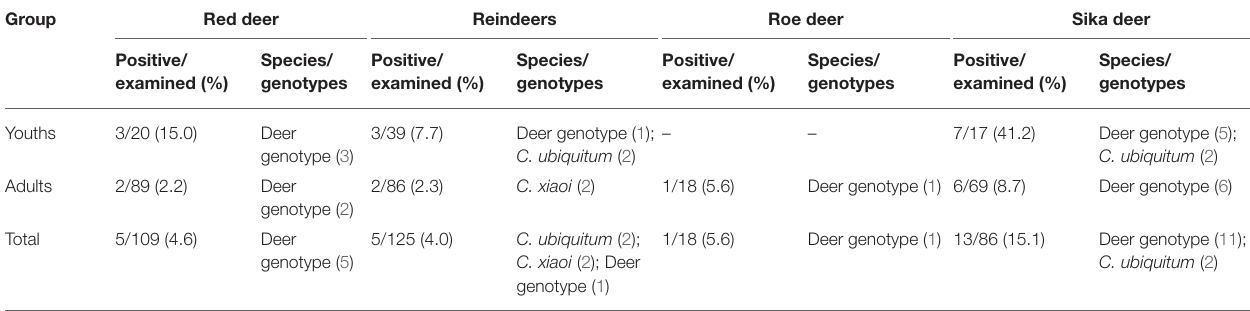
TABLE 3 | Prevalence and Cryptosporidium species/genotypes in the four species of deer according to age. Group Red deer Reindeers Roe deer Sika deer Positive/ examined (%)